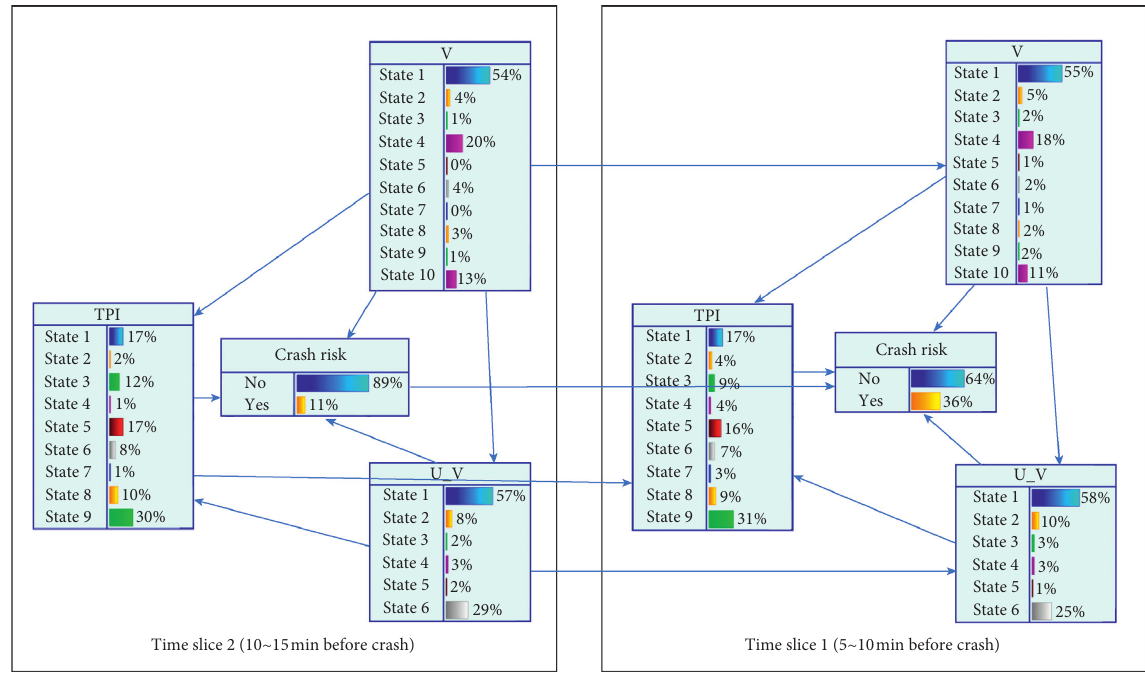
Figure 8: Initial state of the improved DBN-based RTCPM.